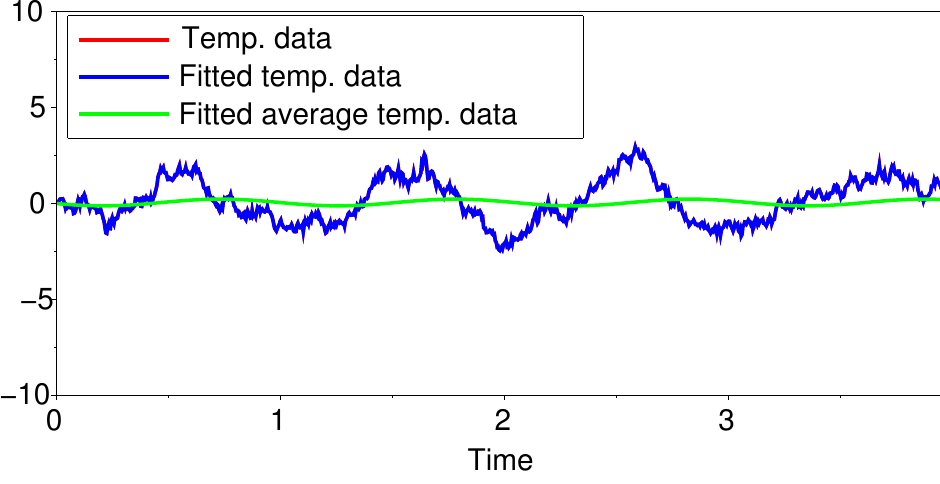
Figure 4. Plot of the theoretical temperature data { T j : j = 1,2, . . . ,1000 } , the fitted temperature data { ˆ T j : j = 1,2, . . . ,1000 } and { E ( ˆ T j ) : j = 1,2, . . . , n } from